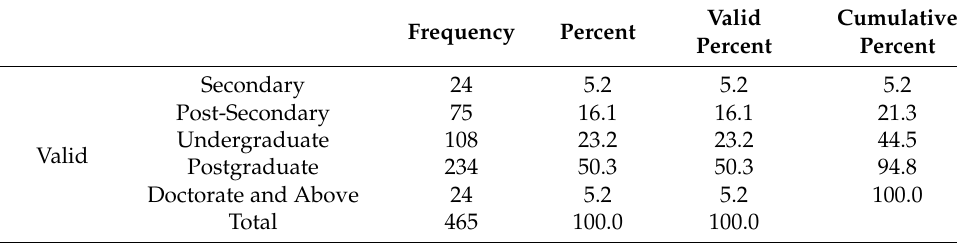
Table 2. Highest level of